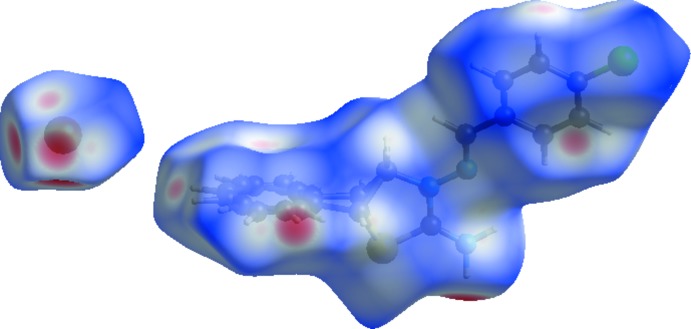
Hirshfeld surface of the title salt mapped with dnorm.